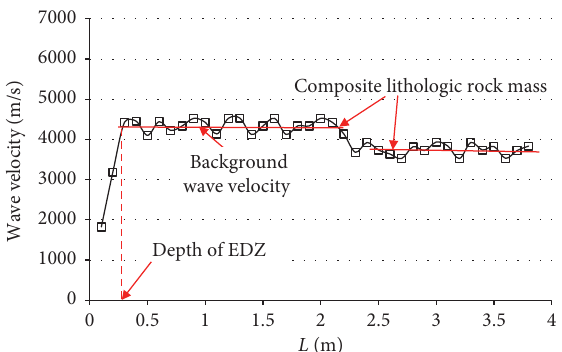
Figure 5: Boundary method used in composite lithologic rock